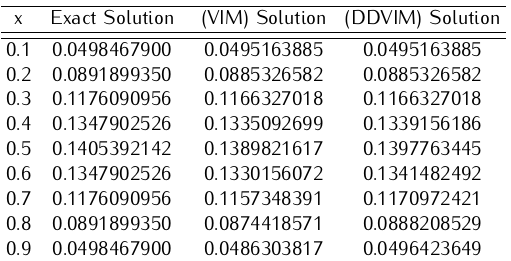
Table 3. Comparison between (VIM) and (DDVIM) when applied to Bratu’s problem for the case λ = 1